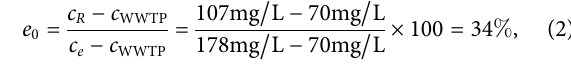
concentration (Liu et al., 2019) and out fl ow fraction which corresponds to the percentage share of the rainfall runoff ( Table 1 ). For untreated wastewater the median value of 143 (IQR (cid:1) 910 – 68) MPs/l was calculated from data of nine studies ( Supplementary Information SI1 ). All considered studies